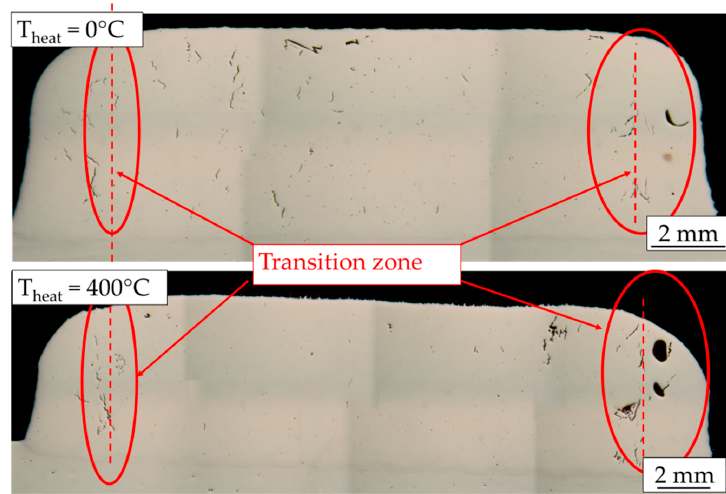
Figure 9. Polished cross sections of samples made out of tool steel powder mixtures with 0.5 wt. % nanoparticles manufactured without ( above ) and with ( below ) additional substrate pre-heating (T heat = 400 °C).